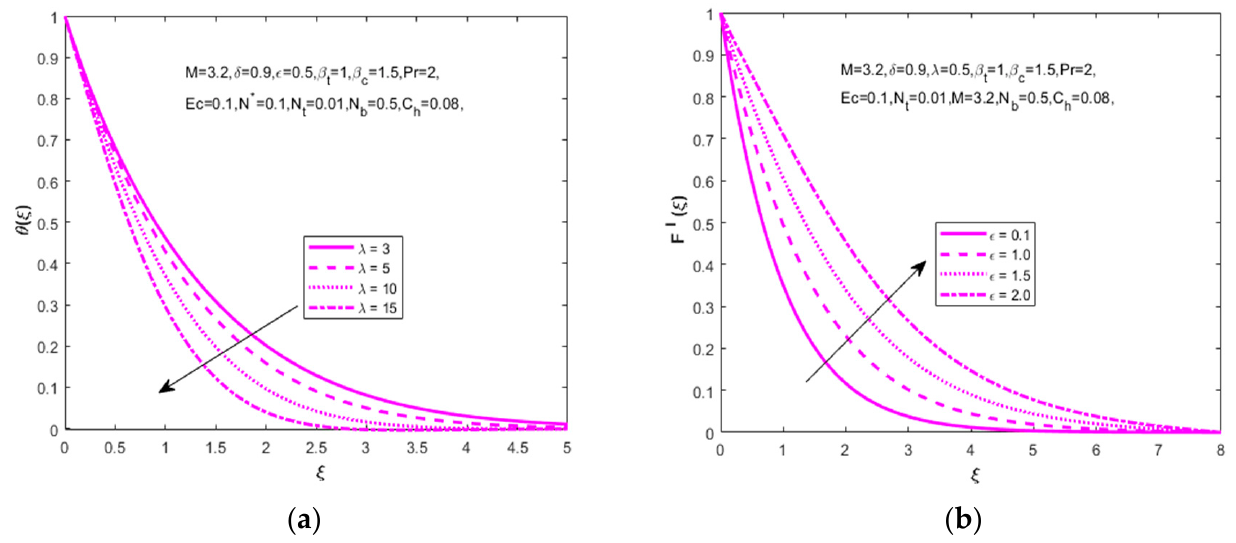
Figure 4. Impact of mixed convection parameter λ on ( a ) temperature ( θ ( ξ )) , fluid parameter ε on ( b ) velocity ( F (cid:48) ( ξ )) , respectively. The influence of ( N b ) is analyzed in Figure 5a,b for several values of the Brownian motion parameter ( N b = 10, 20, 30, 40 ) on temperature distribution ( θ ( ξ )) , and declines in concentration distribution ( Φ ( ξ )) that need to be increased. The Brownian